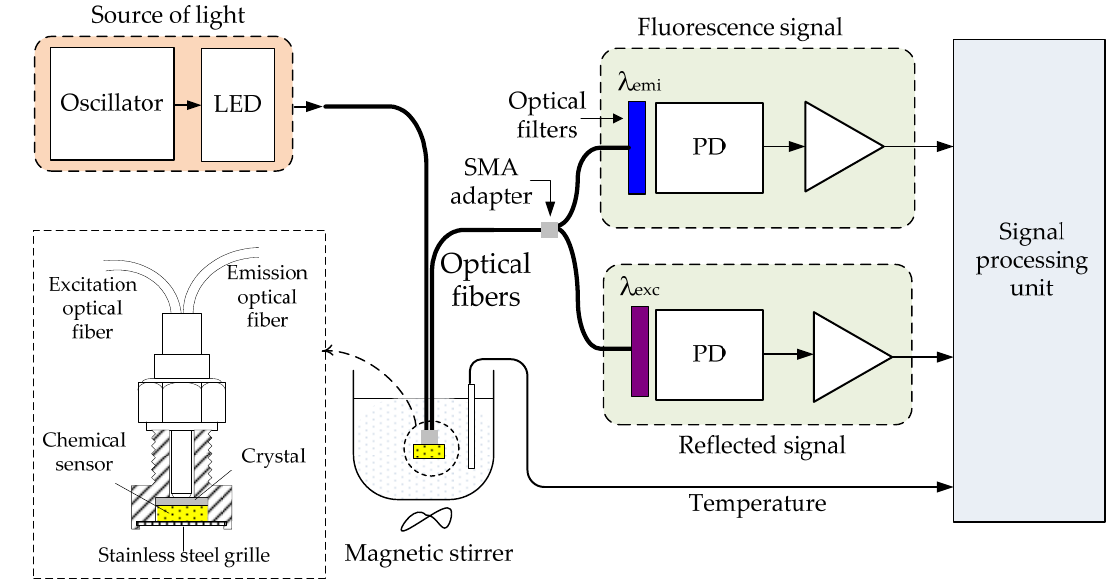
Figure 15. Simplified block diagram of a ratiometric fiber optic pH sensor used for intensity measurements.